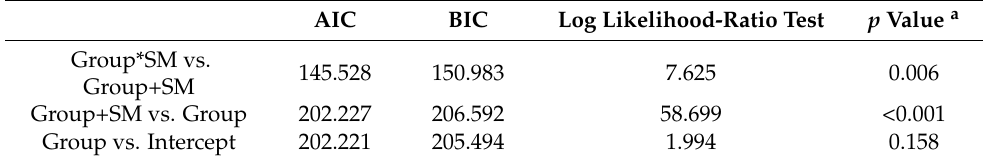
Table 7. Evaluation of the model with the PI